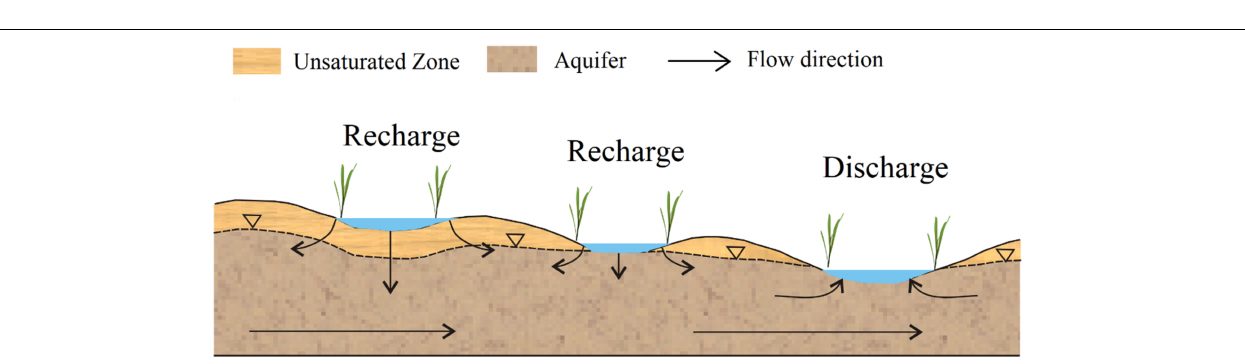
FIGURE 12 | Schematic diagram of local groundwater flow system in wetland (modified from Hayashi et al., 2016).